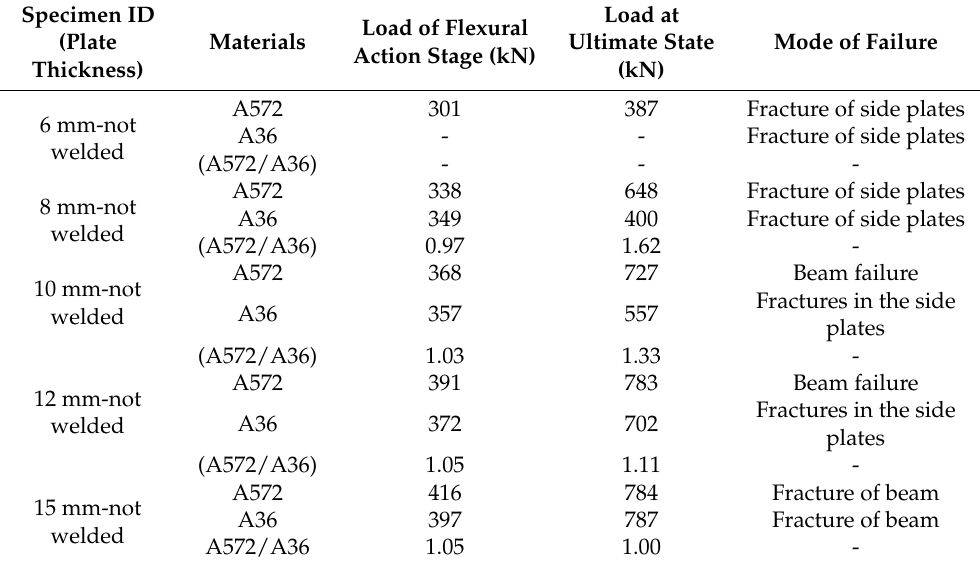
Figure 15. FEM force-displacement response for all A36 steel-specimens.